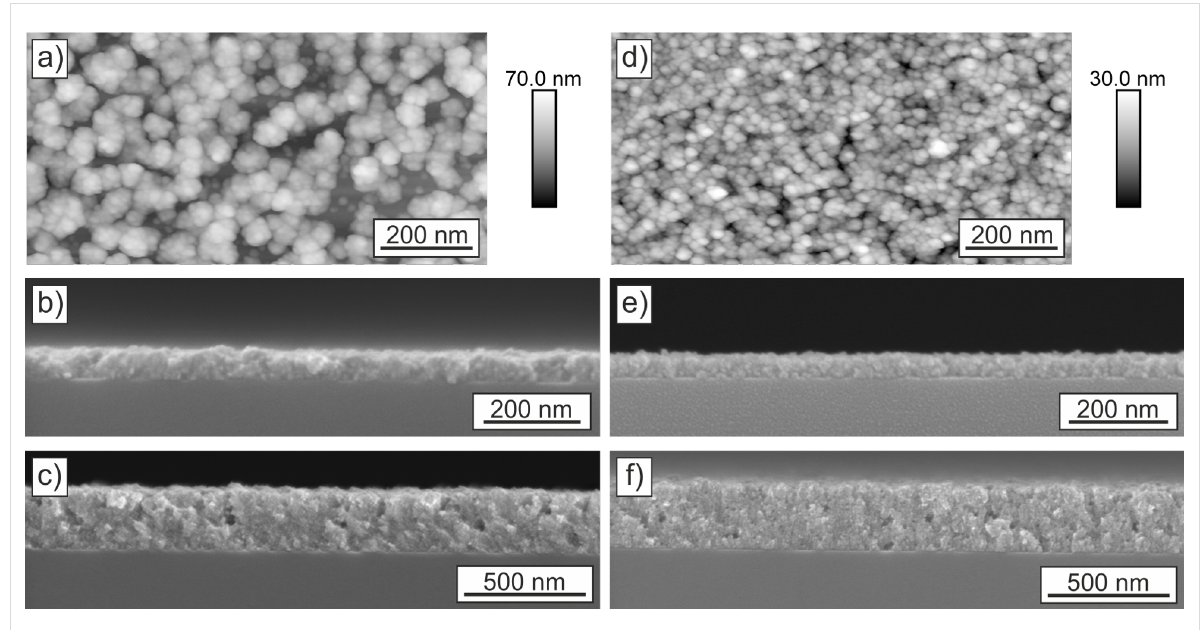
Figure 2: AFM topography images of the ZnO films deposited onto COOH-terminated SAM (a) and PEL (d) after 3 deposition cycles. SEM cross sections of the films after 5 (b,e) and 20 (c,f) deposition cycles on COOH-terminated SAM and PEL (e,f).